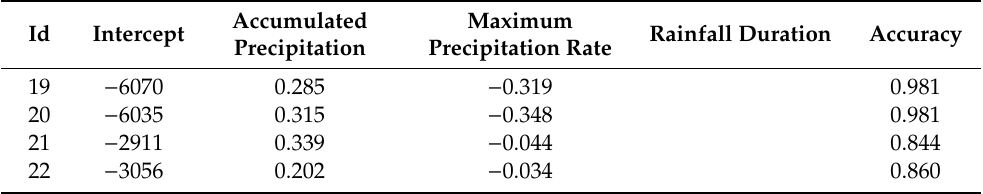
TableA2. Logisticregressionmodelcoe ffi cientsforthetwovariablesincludedaccumulatedprecipitation and a maximum precipitation rate.